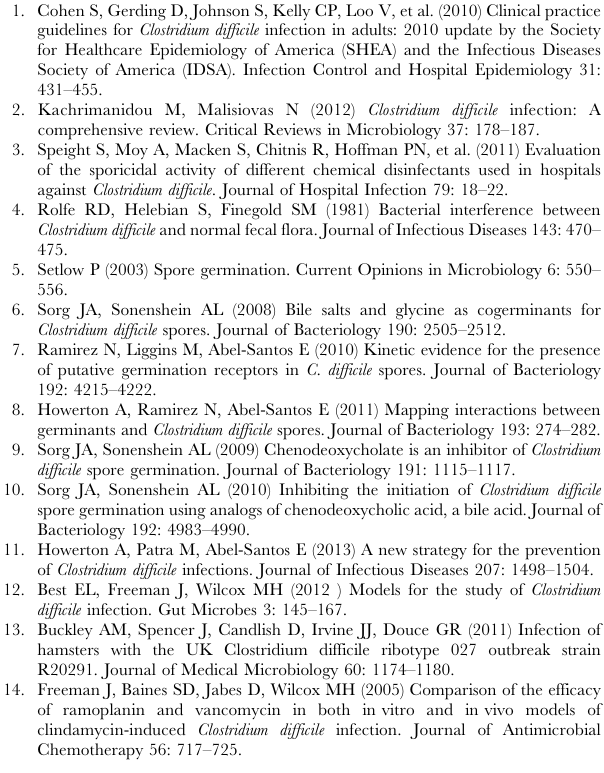
(TIF) Figure S4 CamSA does not affect vegetative bacterial growth. E. coli DH5 a ( % ), B. longum ( # ), L. gasseri ( D ), and C. difficile ( e ) were incubated in media supplemented with 0 or 10 mM CamSA. The OD 580 was recorded at 0, 1, 2, 3, 4, 6, and 8 hours. Growth inhibition was determined by subtracting optical density of CamSA-treated cultures from untreated control cultures. (TIFF) Figure S5 CamSA is not toxic to mammalian cells. Murine macrophages J774A.1 were treated with DMSO (panel A), 10% ethanol (panel B), or 200 m M CamSA (panel C). Cell viability was determined by trypan blue dye exclusion staining (TIFF) Figure S6 Distribution of C. difficile spores in the GI tract of CamSA-treated animals. The stomach (St), duodenum (Du), jejunum (Je), and ileum (Il) showed negligible amounts of spores compared to the cecum (Ce) and colon (Co). (TIFF) Table S1 CamSA permeability across Caco-2 cell monolayer a